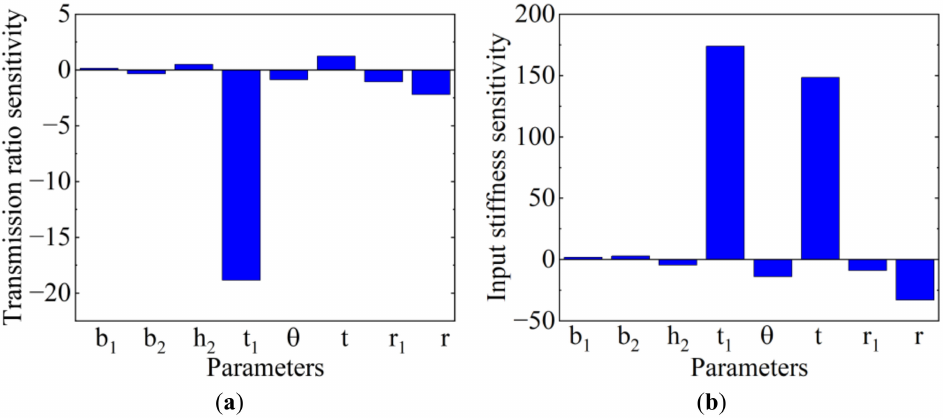
Figure 7. Sensitivity analysis results. ( a ) Transmission ratio sensitivity. ( b ) Input stiffness sensitivity.